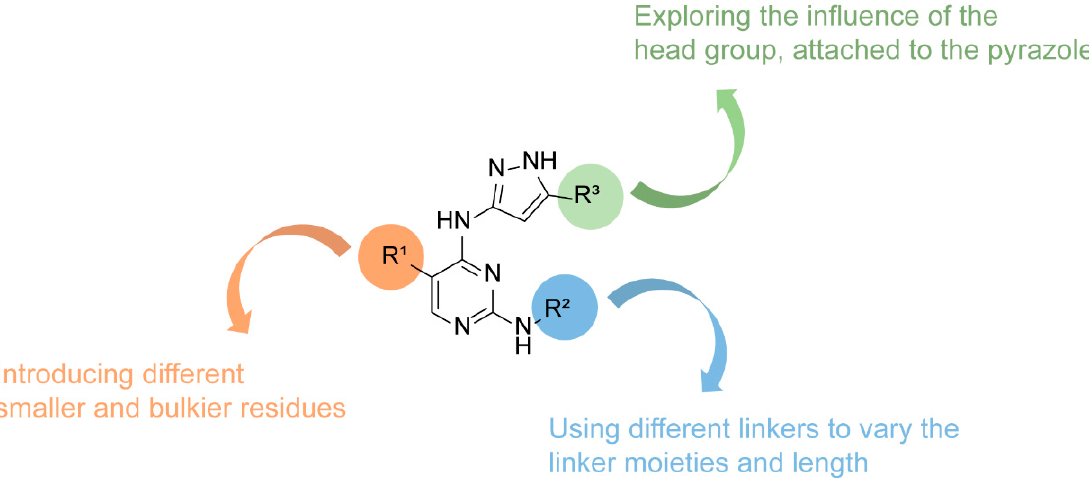
Figure 3. Summary of modifications, using 1 – 3 as the lead structure.